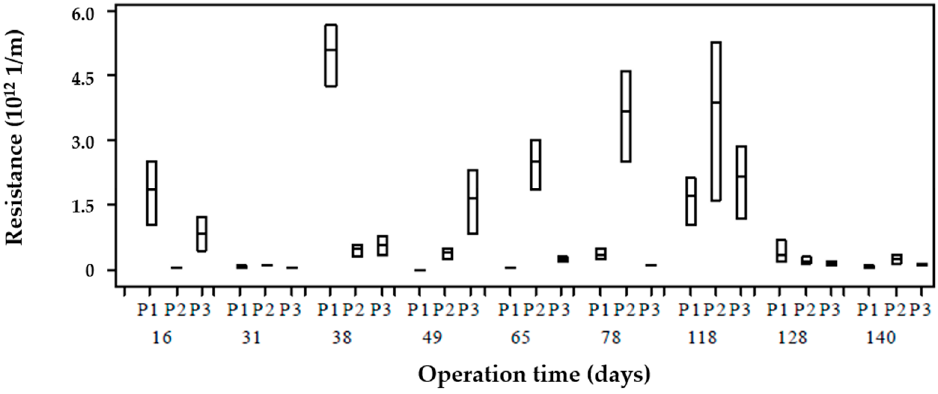
Figure 6. Membrane resistance distribution at each point over operation time.